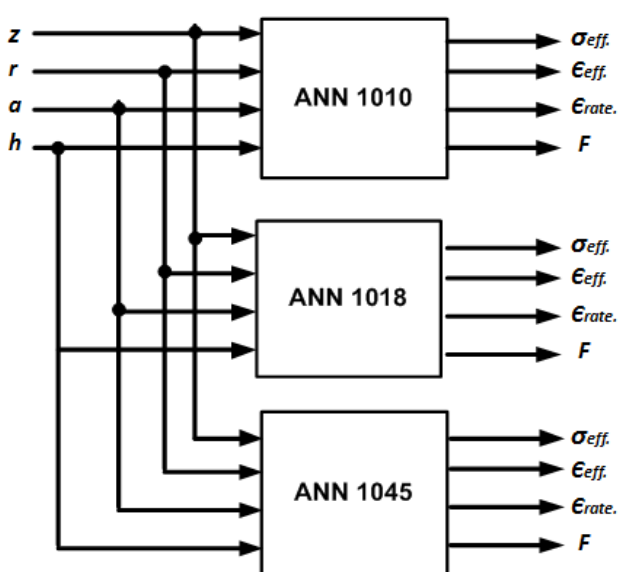
Figure 3. ANN Architecture of current investigation.